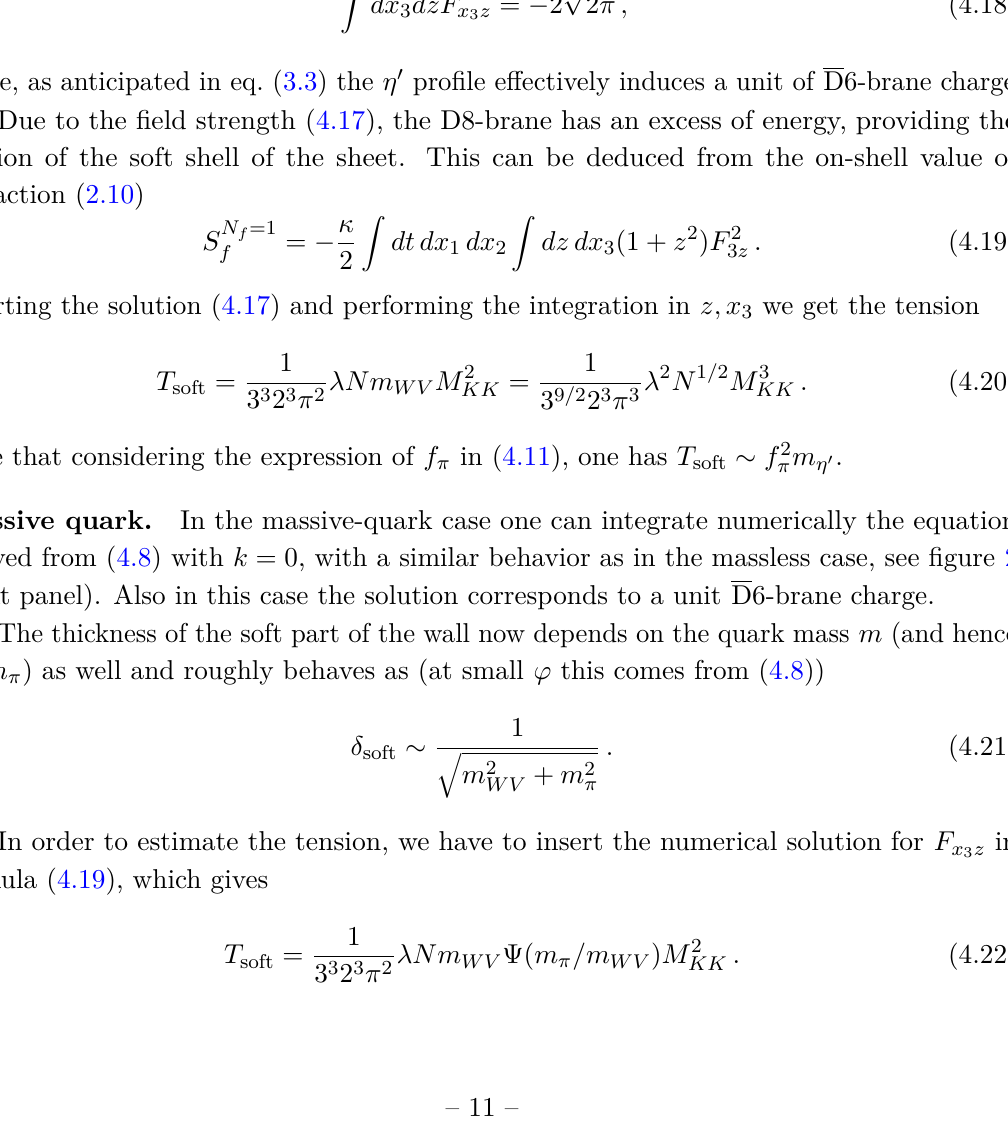
Figure 2 . Left: the profile of ϕ = lines). Right: the profile of ϕ for m yellow and red